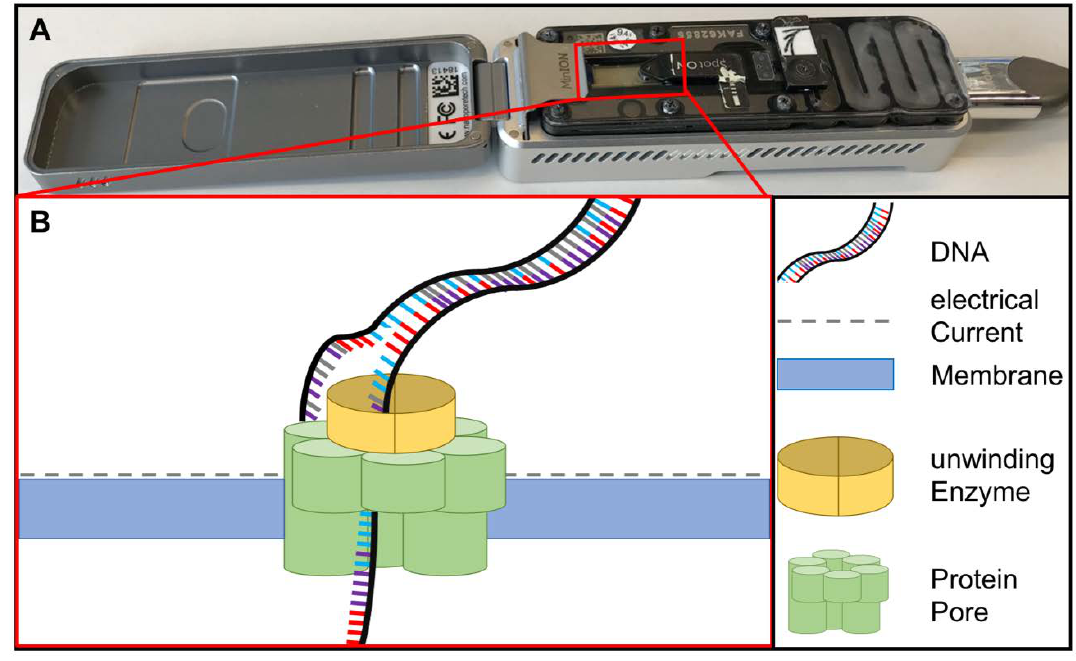
Figure 4. ( A ) MinION sequencing device (Oxford Nanopore technology, Cambridge, UK) and ( B ) the principle of nanopore sequencing. A protein pore is embedded in a membrane set under a certain electrical current. As the DNA molecule passes through the pore each nucleotide is recognized by the individual change caused in the voltage.